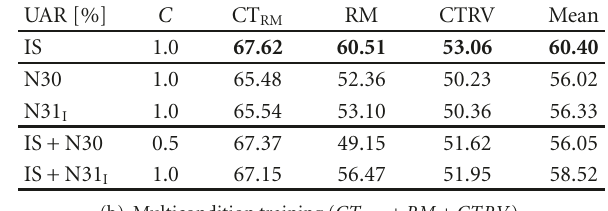
Table 4: Results on the Aibo 2-class problem (7886 test instances in each of the CT RM , RM, and CTRV versions) for di ff erent training conditions. All results are obtained with SVM trained by SMO with complexity parameter C , which was optimized on the development set (see Figure 2). “UAR” denotes unweighted average recall. “IS” is the baseline feature set (INTERSPEECH 2009 Emotion Challenge) while “N30” and “N31 I ” are NMF features obtained using supervised and semisupervised NMF (see Table 3). “+” denotes the union of feature sets. “Mean” is the arithmetic mean over the three test conditions. The best result per column is